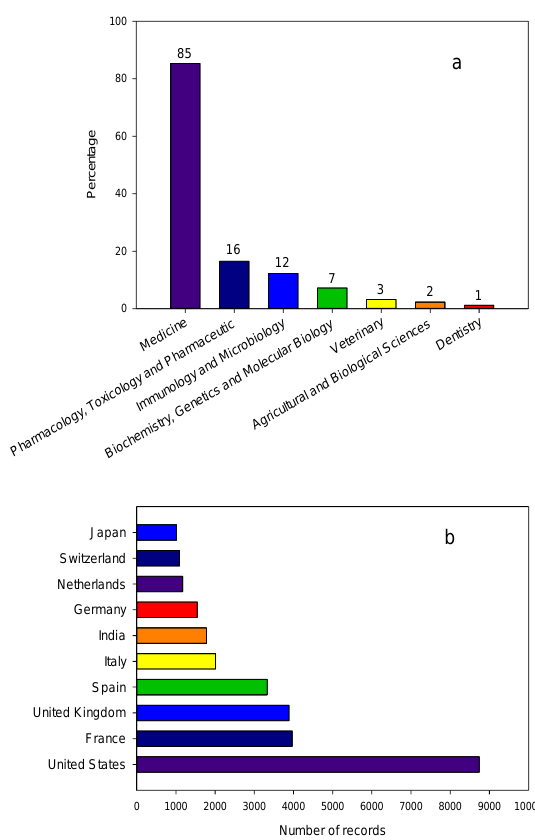
Figure 2. Summary of publications on clavulanic acid between 1975 and 2017. ( a ) Documents grouped by areas. Note: percentages add up to more than 100 because a document can be indexed in more than one area. Other areas contributed 6.2%. ( b ) Top 10 leading countries in the field of clavulanic acid.